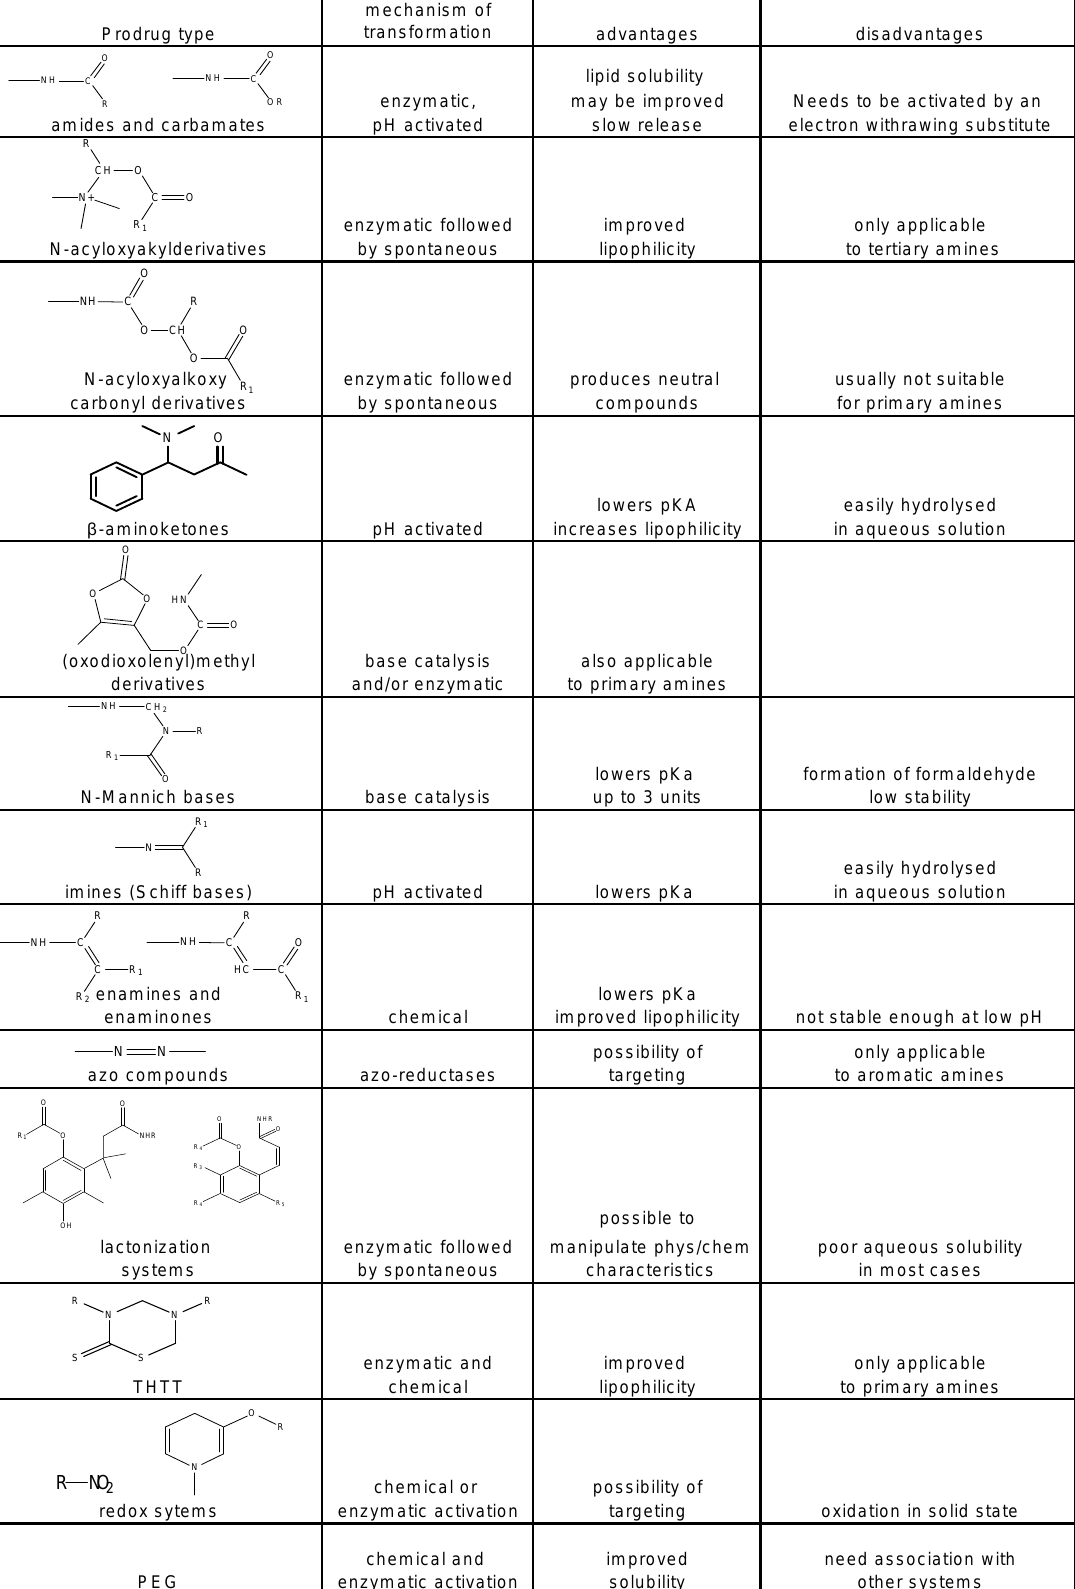
Table 1 . Compilation of a series of published prodrug approaches to amine drugs. Prodrug